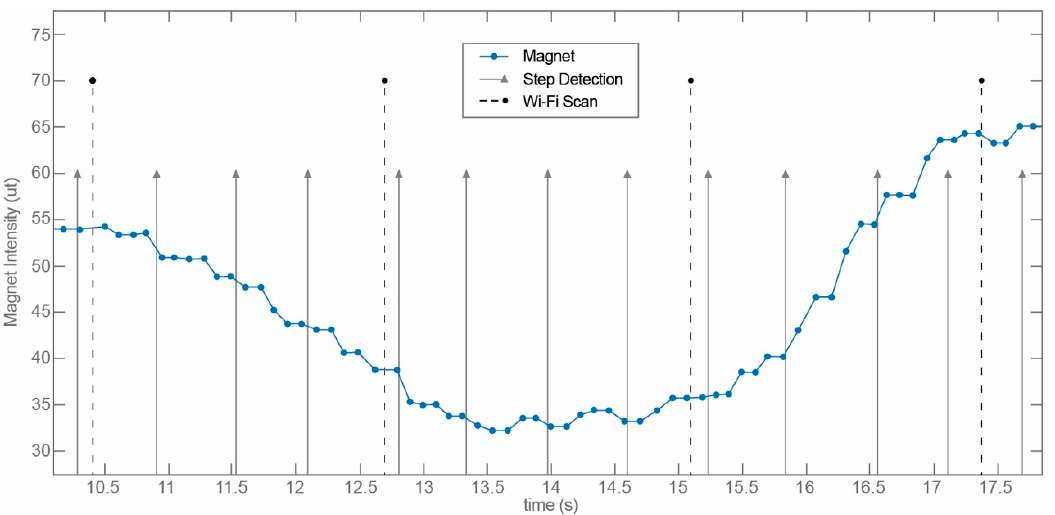
Figure 1. Positioning time of each sensor over time (geomagnetic data have an approximately 100-ms positioning period, with other sensors exceeding this speed).